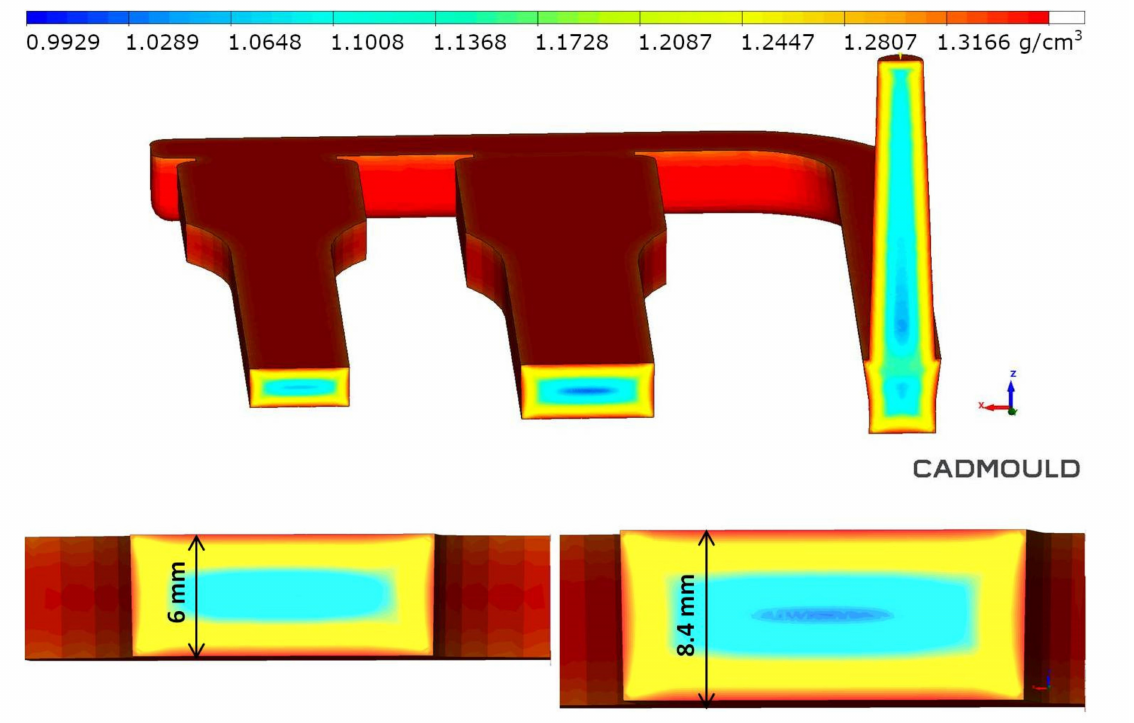
Figure 25. Density distribution in the measuring cross-section of 6mm and 8.4 mm thick polyamide test specimens. The gas volume fraction calculated in the simulation corresponds to the weight loss obtained under real conditions. In the transition layer, which is crucial due to its mechanical properties, the gas volume fraction ranged from 4% to 8% (Figure